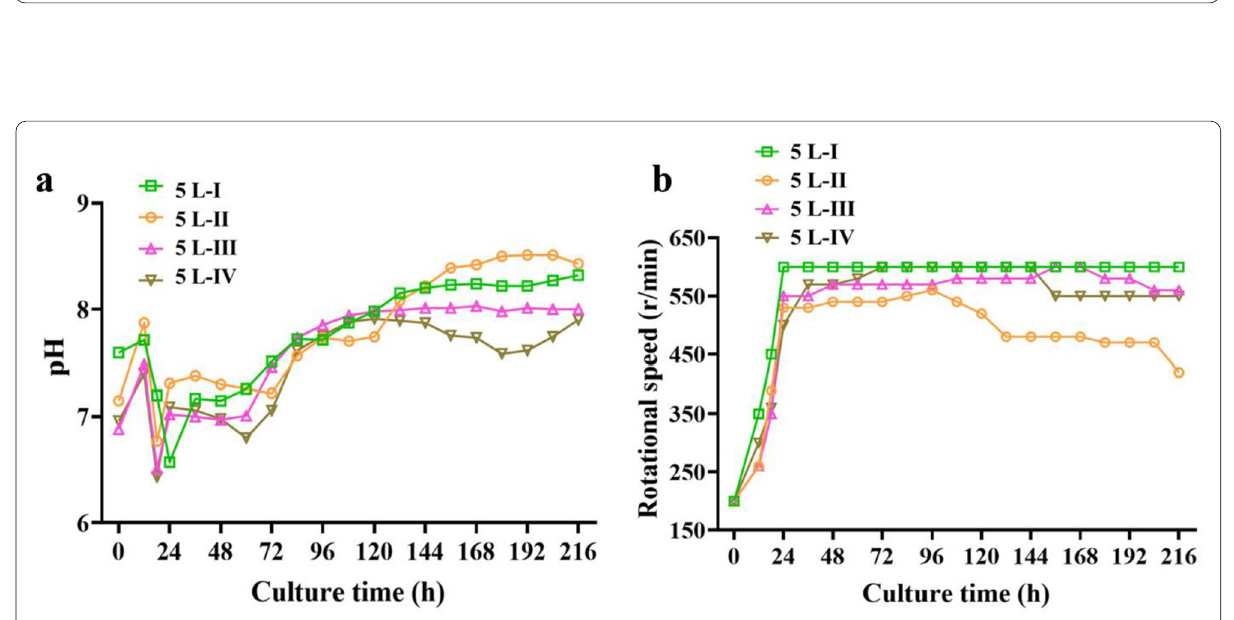
Fig. 9 Time courses of ilamycins E 1 /E 2 production, pH value, DCW, dissolved oxygen (DO), rotational speed and residual sugar in 5-L bioreactor (batch I–IV)